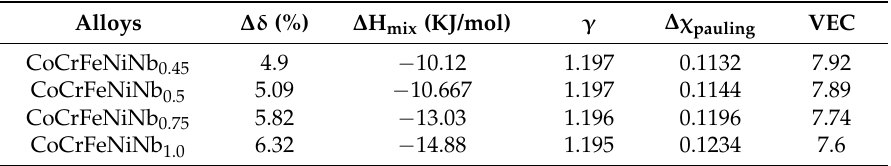
Table 1. The parameters of Δδ , Δ H mix , Δχ pauling , γ , and valence electron concentration (VEC) for the CoCrFeNiNb x HEA coatings.